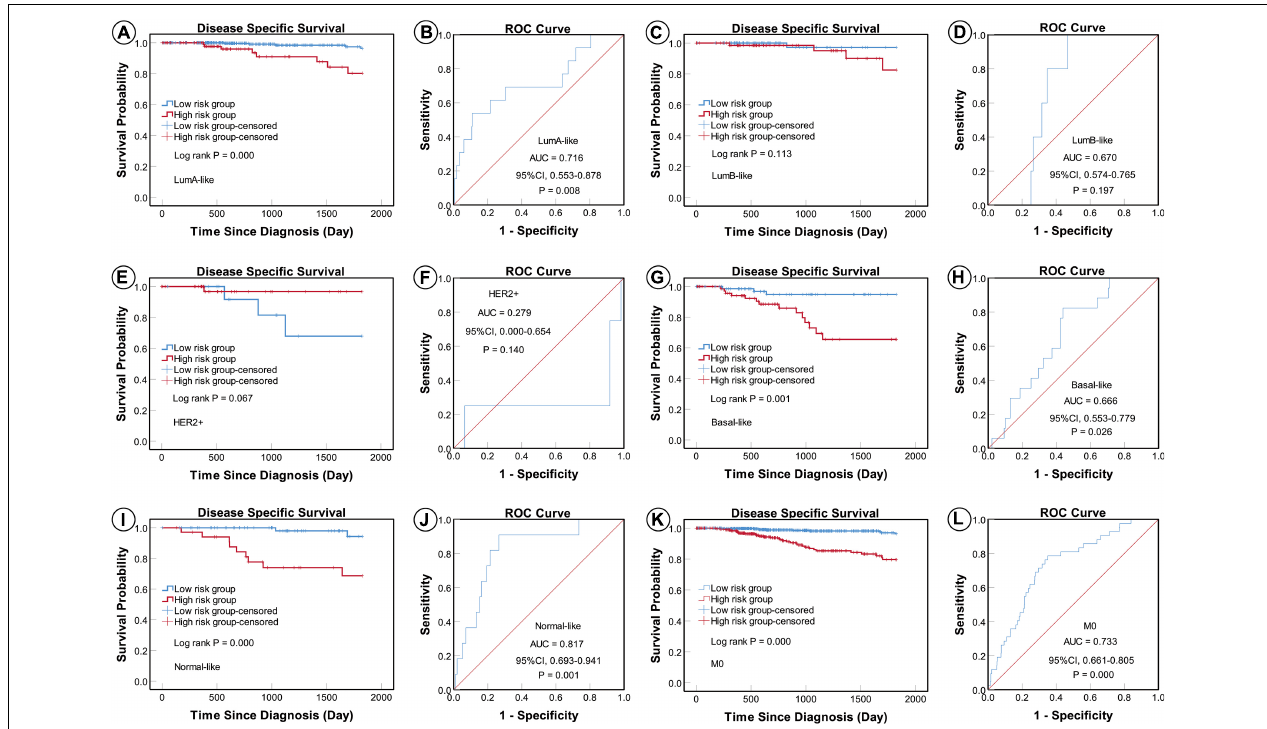
FIGURE 7 | KM and ROC curves for patients stratified by molecular subtype and metastasis status. KM analysis showed that patients in the low-risk group had significantly better DSS in the LumA-like (A) , basal-like (G) , normal-like (I) , and M0 (K) subgroups, but not in the LumB-like (C) or HER2 (E) subgroups. ROC analysis showed that the five-miRNA signature exhibited high sensitivity and specificity in predicting the prognosis of patients with BC in the LumA-like (B) , basal-like (H) , normal-like (J) , and M0 (L) subgroups, but not the LumB-like (D) or HER2 (F) subgroups.